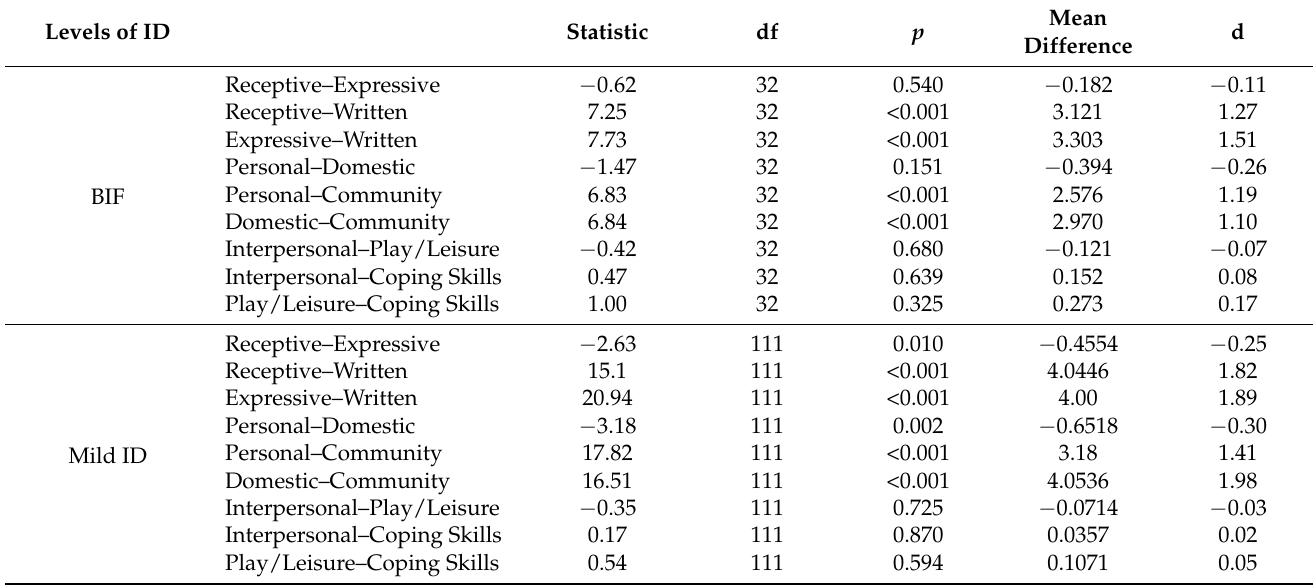
Table A4. Paired-samples t -test for subdomains in domains of VABS-3 for each level of